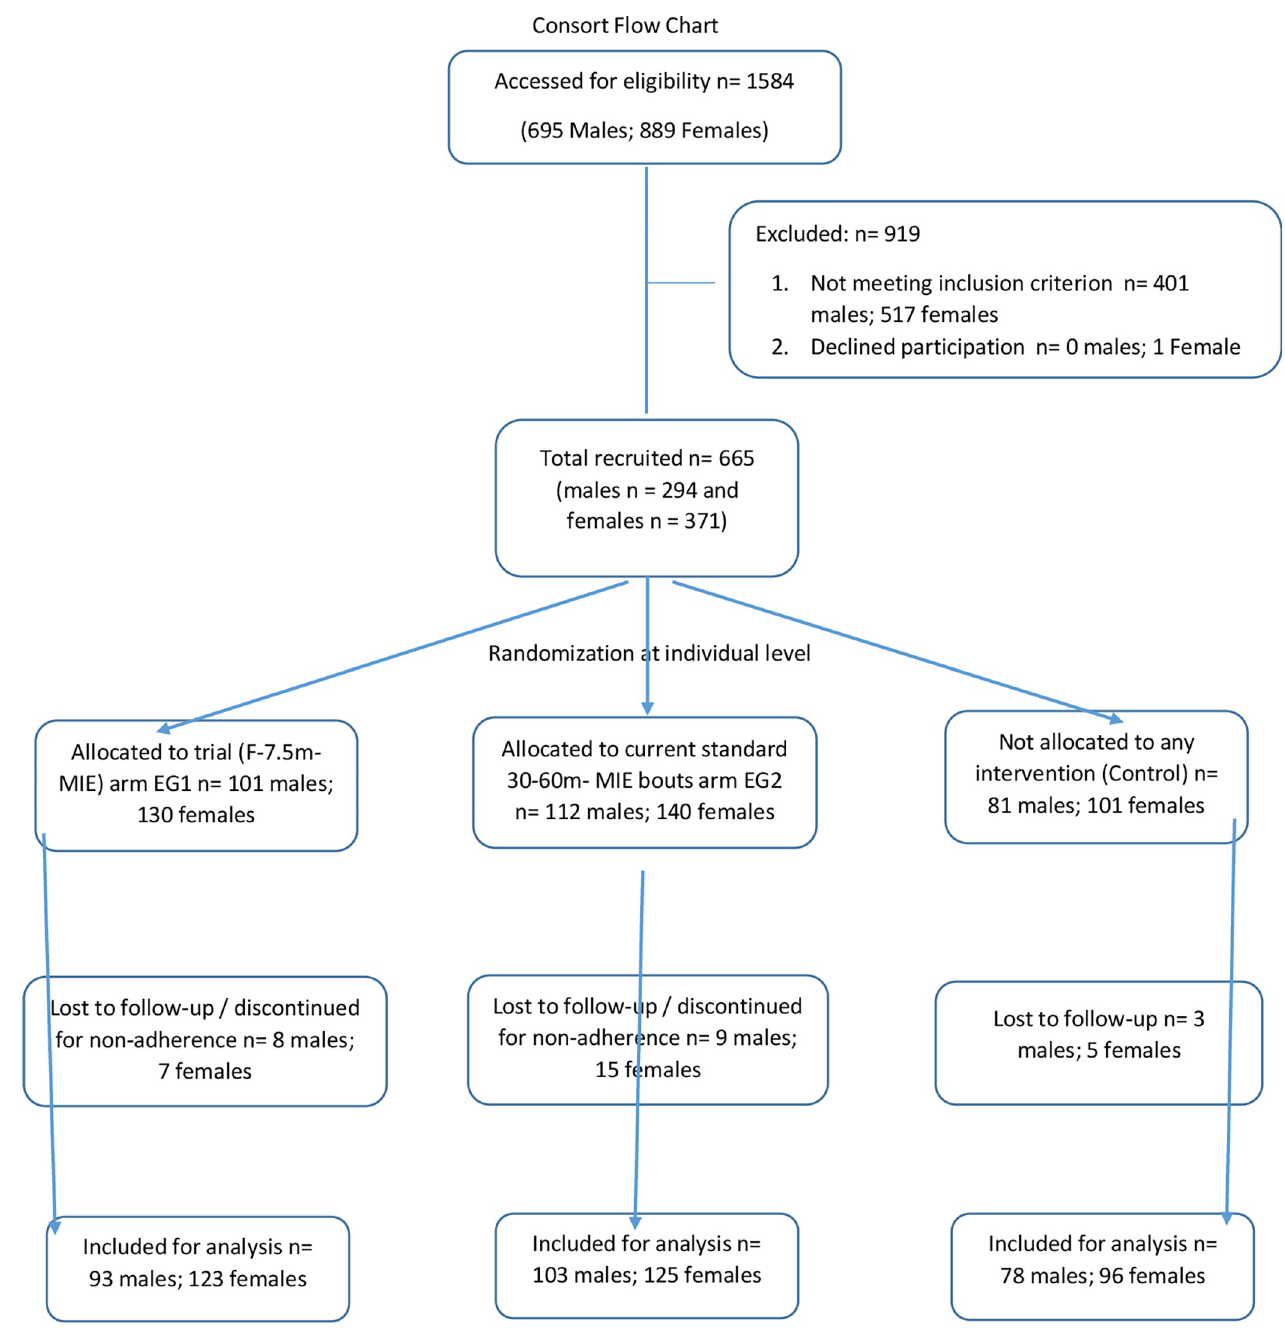
Fig 1. Participants recruitment and follow